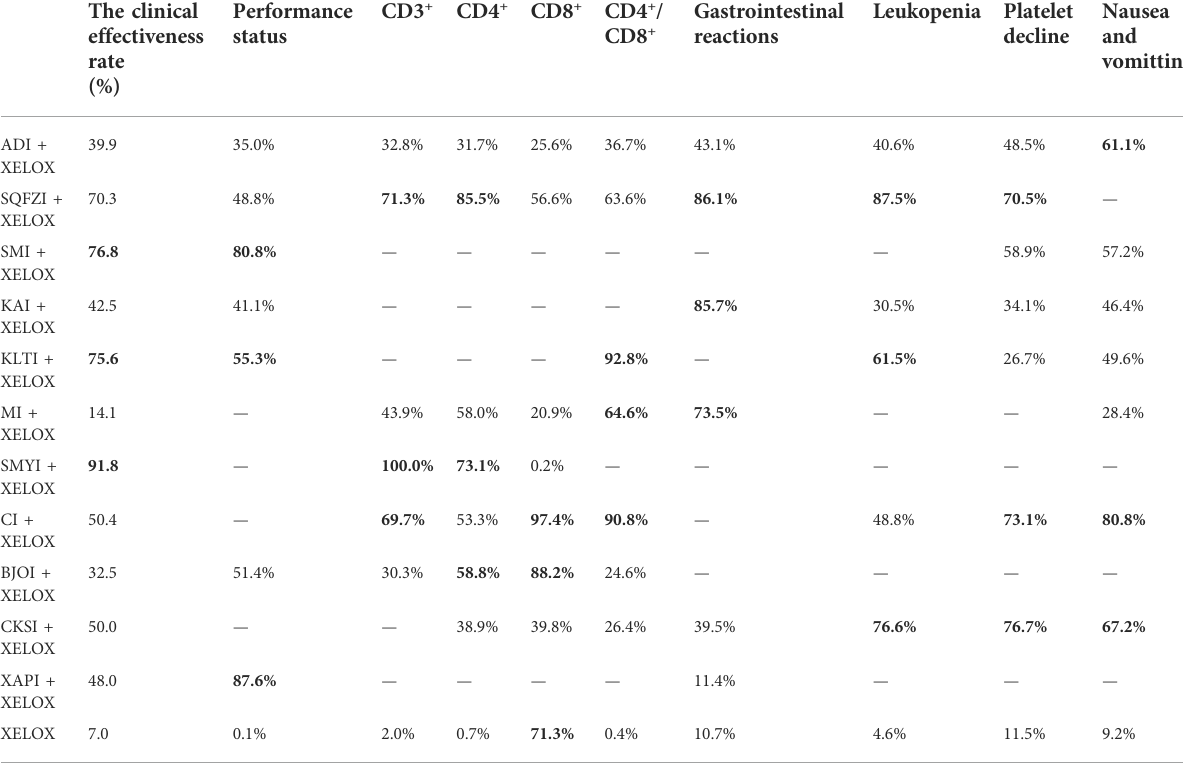
TABLE 7 SUCRA values of different groups for